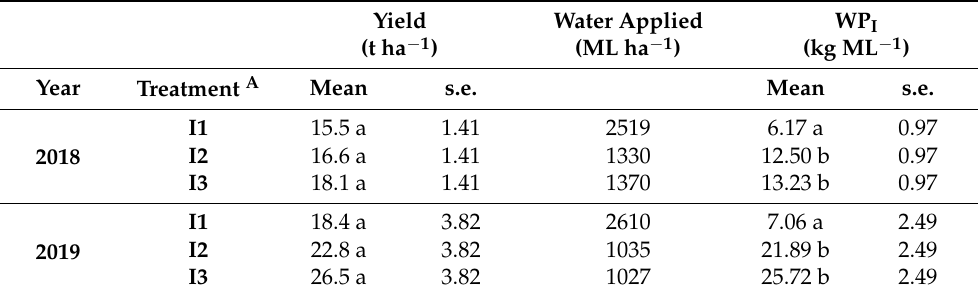
Table 5. Yield, water applied, and irrigation water productivity (WP I ) measured in two experiments at National University of Laos, Nabong, Xaithany district, Vientiane province, Laos. Different letters in the same column for each year signify statistically significant differences p <